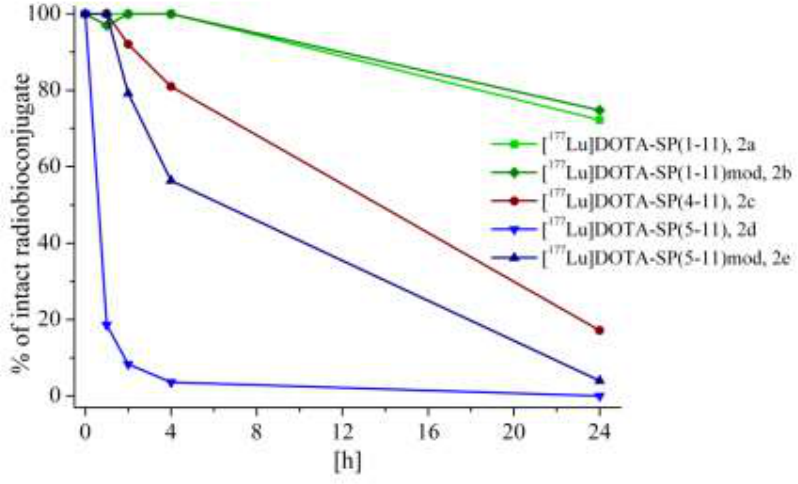
Figure 4. Stability studies of [ 177 Lu]DOTA-SP, 2a–e , radiobioconjugates in human serum.